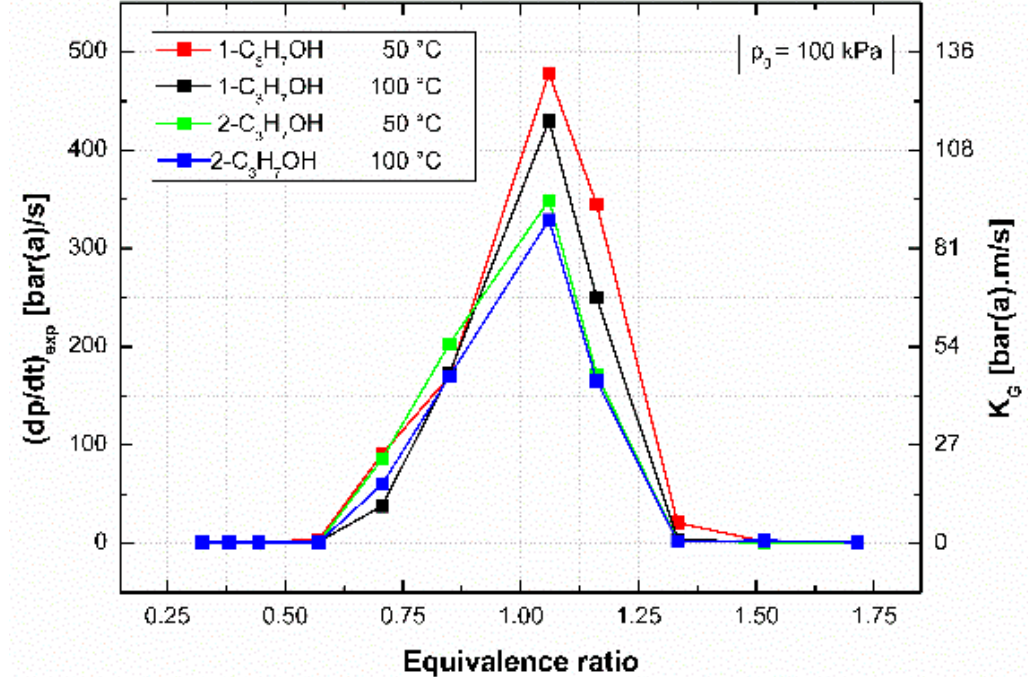
Figure 8. (dp/dt) ex versus Φ = 0.3–1.7 for propanol isomer–air mixtures at various initial temperatures and mixture compositions, p 0 = 100 kPa.